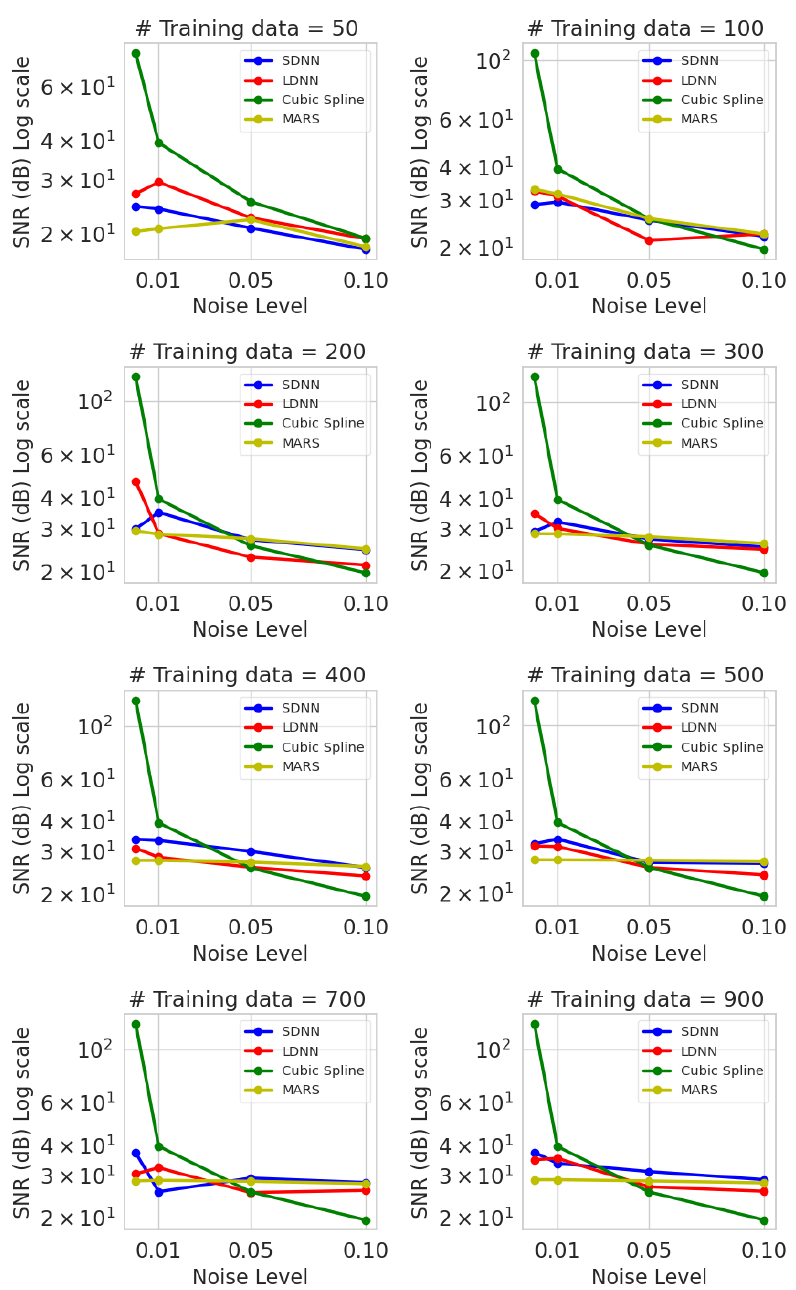
Figure 7. SNR vs. noise level (0%, 1%, 5%, 10%) for eight different levels of sparsity (sample training points) computed on the test set predictions and ground truth. The average values over five runs are presented. Blue represents SDNN, red LDNN, green cubic splines, and yellow